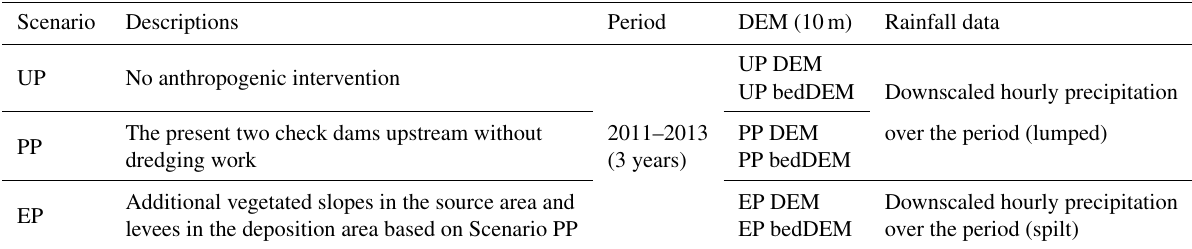
Table 1. Scenario